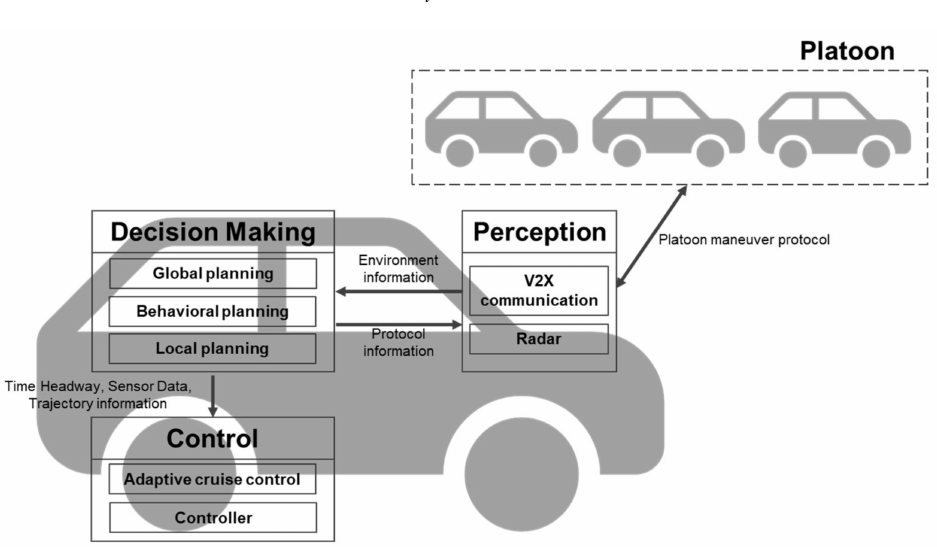
Figure 2. An architecture of a platooning system for connected and automated